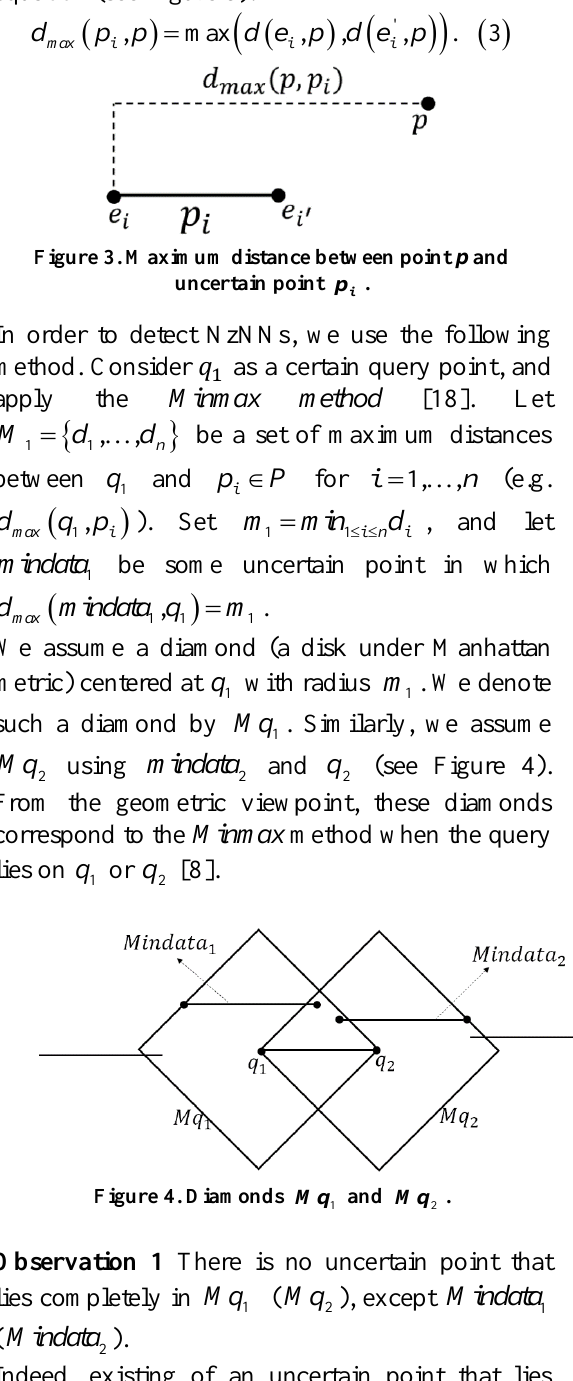
Figure 4. Diamonds